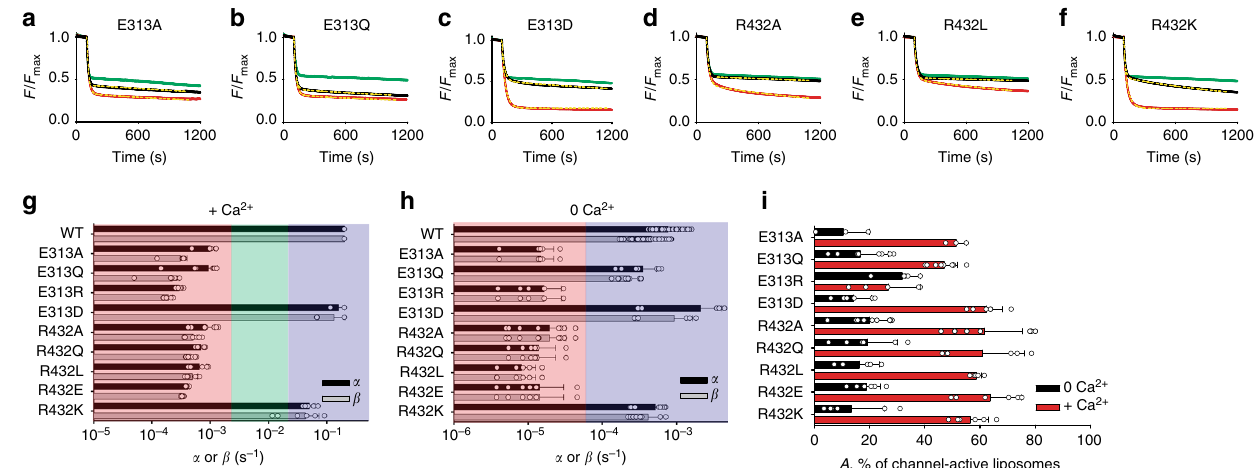
Fig. 8 The charge of E313 and R432 is essential for lipid scrambling. a – f Time course of dithionite-induced fl uorescence decay for the indicated nhTMEM16 mutants of E313 and R432 in the presence (red) and absence (black) of Ca 2 + . Dashed yellow lines indicate fi ts to Eq. (6). Protein-free traces are shown in green. g , h Quanti fi cation of scrambling rate constants α and β for WT and mutant nhTMEM16 in the presence ( g ) and absence of Ca 2 + ( h ). The effects were categorized as in Fig. 2g, h. Individual data points are shown as empty circles. i Fraction of the liposomes containing at least one active channel in the presence (red) and absence of Ca 2 + (black). All data is reported as the mean ± S.D. The number of replicates are indicated in Supplementary Table